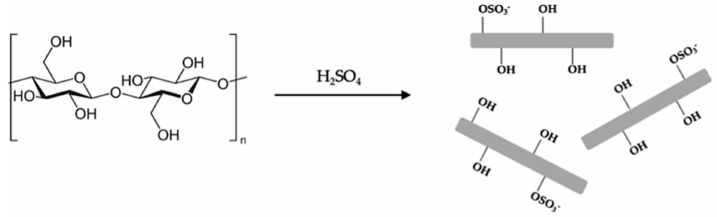
Figure 1. Cellulose hydrolysis by sulfuric